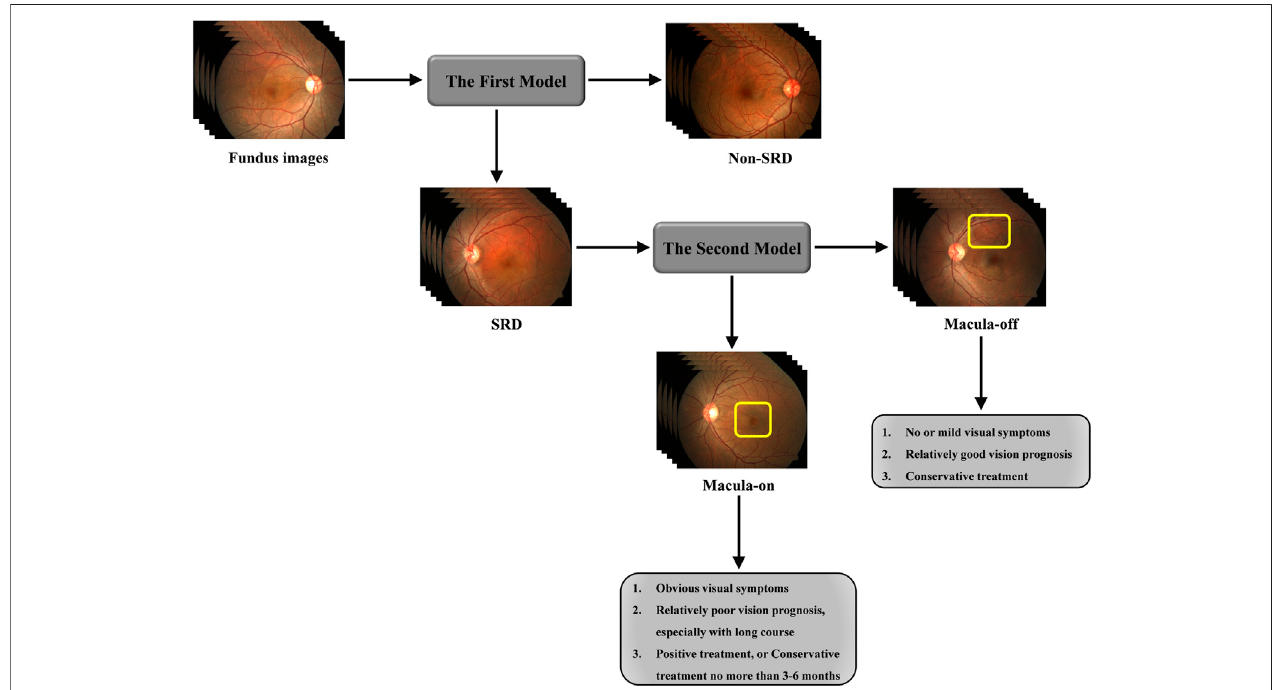
FIGURE 3 | Framework ofcascaded deep learning system and its corresponding clinical application. CSC often has a halo-like appearance in macularegions due to SRD. Top left, A fundus image of a normal subject without SRD; Top middle, A fundus image of a patient with SRD at macula; Top right, A fundus image of a patient with SRD away from macula (circled in yellow). SRD, serous retinal detachment; CSC, central serous